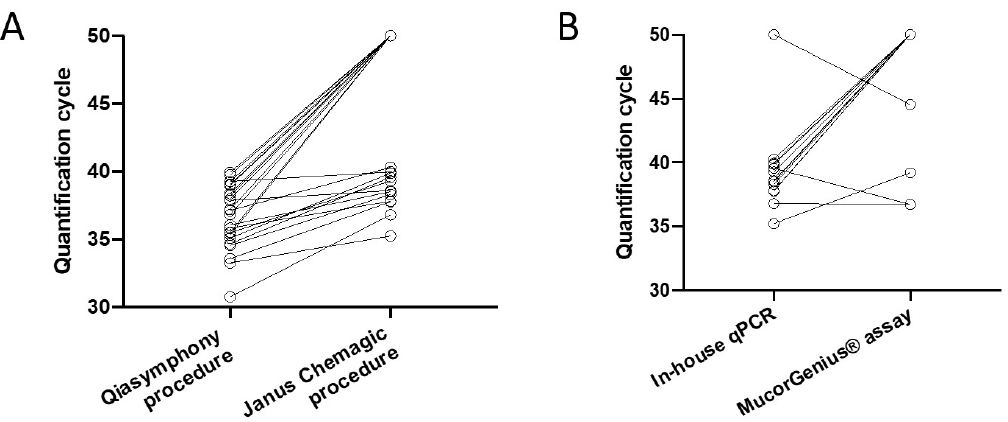
Figure 1. ( A ) Difference in quantification cycle (Cq) values between the initial result at diagnosis and the present study using a different DNA extraction protocol (Qiasymphony versus Janus Chemagic procedure) although using the same amplification protocol. Out of the 25 serum specimens, 13 specimens turned negative with the in-house qPCR and an increase in Cq value was observed with the Janus Chemagic procedure versus the Qiasymphony procedure (median [IQR]: 38.5 (37.8–39.8) and 35.3 (33.8–36.84), respectively; p < 0.001), Wilcoxon matched-pairs signed rank test). The initial Cq values of the serum samples that turned negative were significantly higher compared to the initial Cq values of the serum samples currently positive with the in-house qPCR (38.4 (37.0–39.2) and 35.3 (33.8–36.8), respectively; p = 0.002, unpaired Mann–Whitney test]. Negative results were attributed a Cq of 50. ( B ) Comparison of PCR assays using the Janus Chemagic procedure based on patient spec-imens. Thirteen serum specimens were amplified by at least one qPCR assay (in-house or Mucor-Genius ® qPCR). Negative results were attributed a Cq of